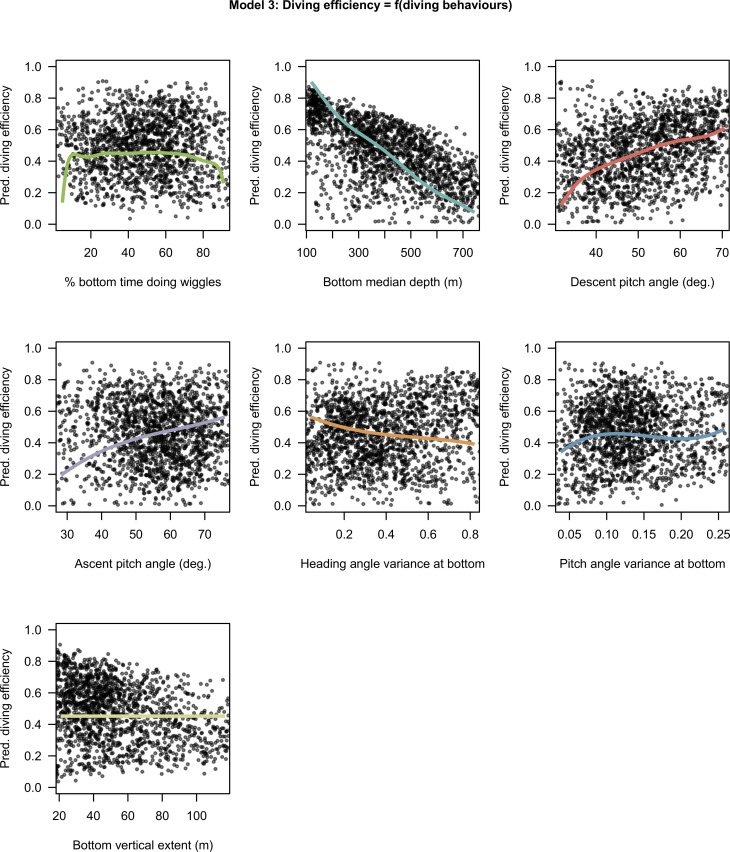
Estimated effects of covariates selected in model 3. The predictions for each covariate varying from the 5% to the 95% quantile of observed values with other covariates at their mean. The x axes have been scaled to range from -2 to 2 normalized so that regression slopes are comparable but are annotated with raw units so that units are comprehensible.